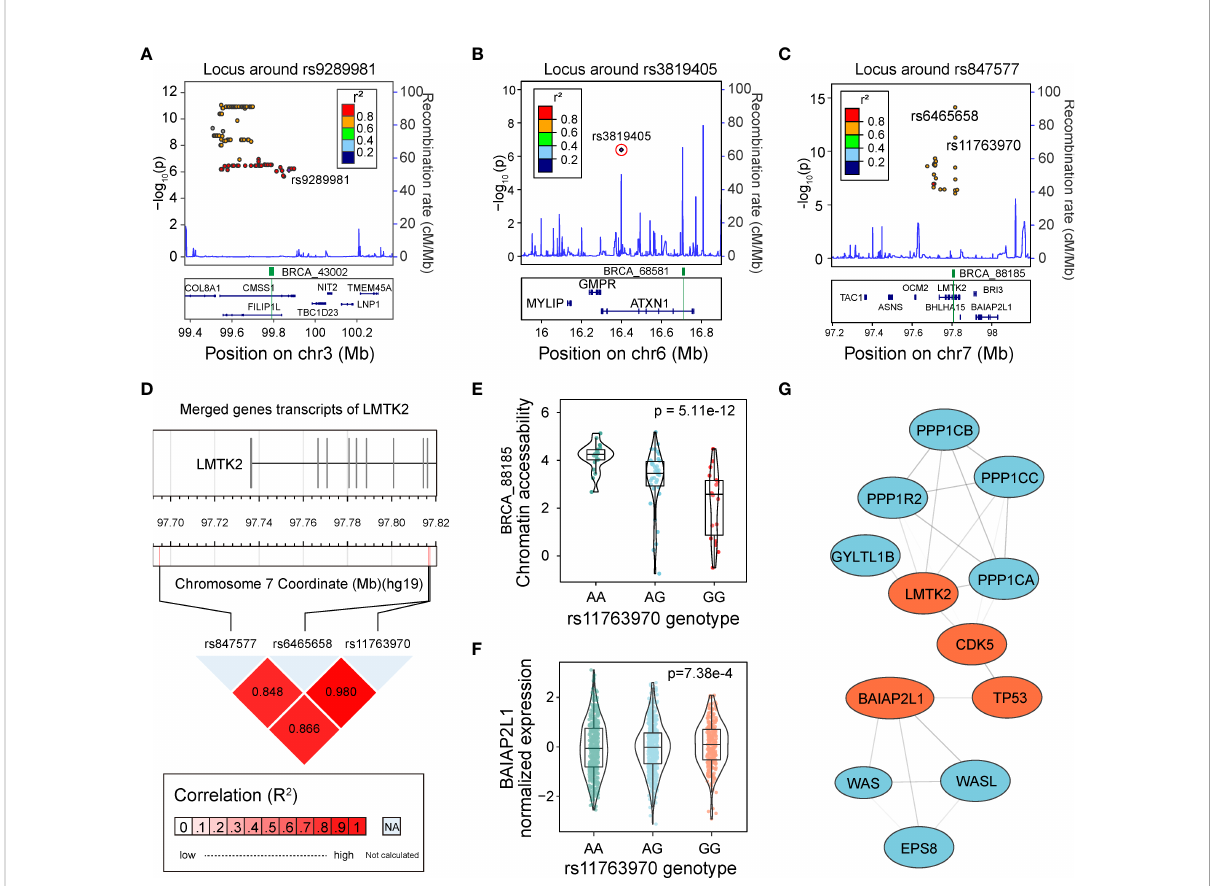
FIGURE 5 Identi fi cation of regulatory caQTLs at GWAS loci. (A) Locus plot shows the LD region of rs9289981. caQTL is marked in purple rhombus, and the caQTL peak is highlighted in green. (B) The locus plot shows the LD region of rs3819405. caQTL is marked in a circled purple rhombus, and the caQTL peak is highlighted in green. (C) The locus plot shows the LD region of rs847577. The caQTL rs11763970 and rs6465658 are marked, and the caQTL peak is highlighted in green. (D) The linkage disequilibrium (LD) of the GWAS tag SNP rs847577, caQTL variant rs11763970, and caQTL variant rs6465658. (E) Distribution of chromatin accessibility of BRCA_88185 in groups with different genotypes of rs11763970. (F) Distribution of expression of BAIAP2L1 in groups with three different genotypes of rs11763970. (G) Protein-protein network of gene BAIAP2L1 and LMTK2 , both of which interact with TP53 . Genes involved in the interaction are highlighted in